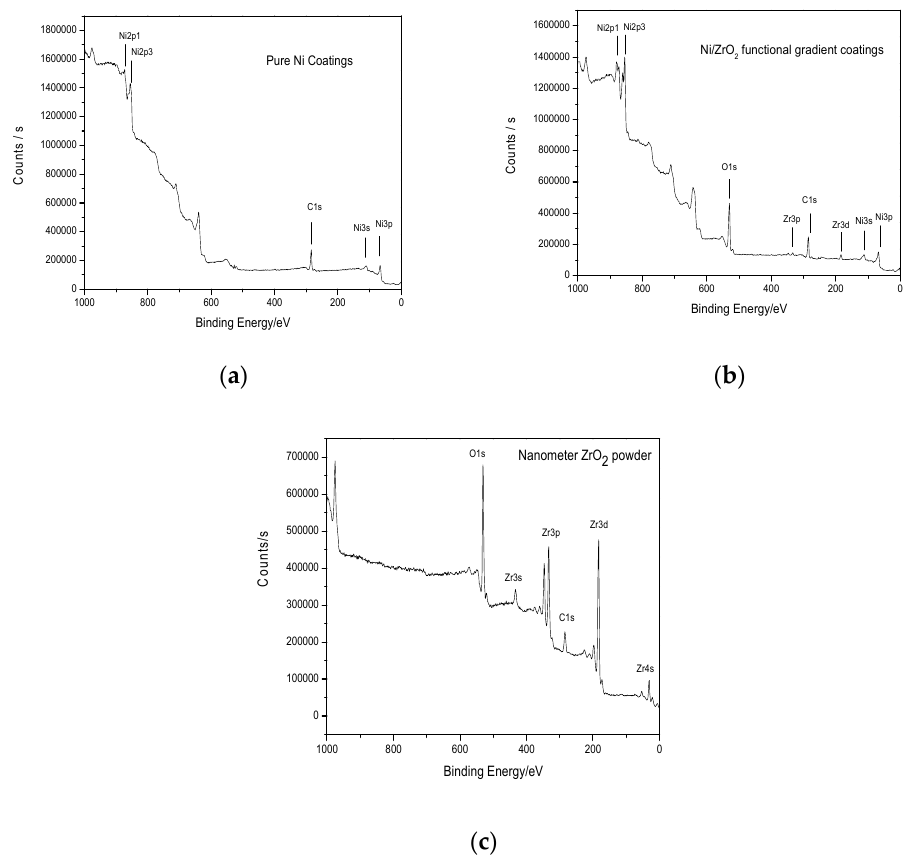
Figure 13. XPS spectrum of ZrO 2 . ( a ) Pure Ni coatings; ( b ) Ni/ZrO 2 functional gradient coatings; ( c ) Nanometer ZrO 2 powder. ( c ) Nanometer ZrO 2